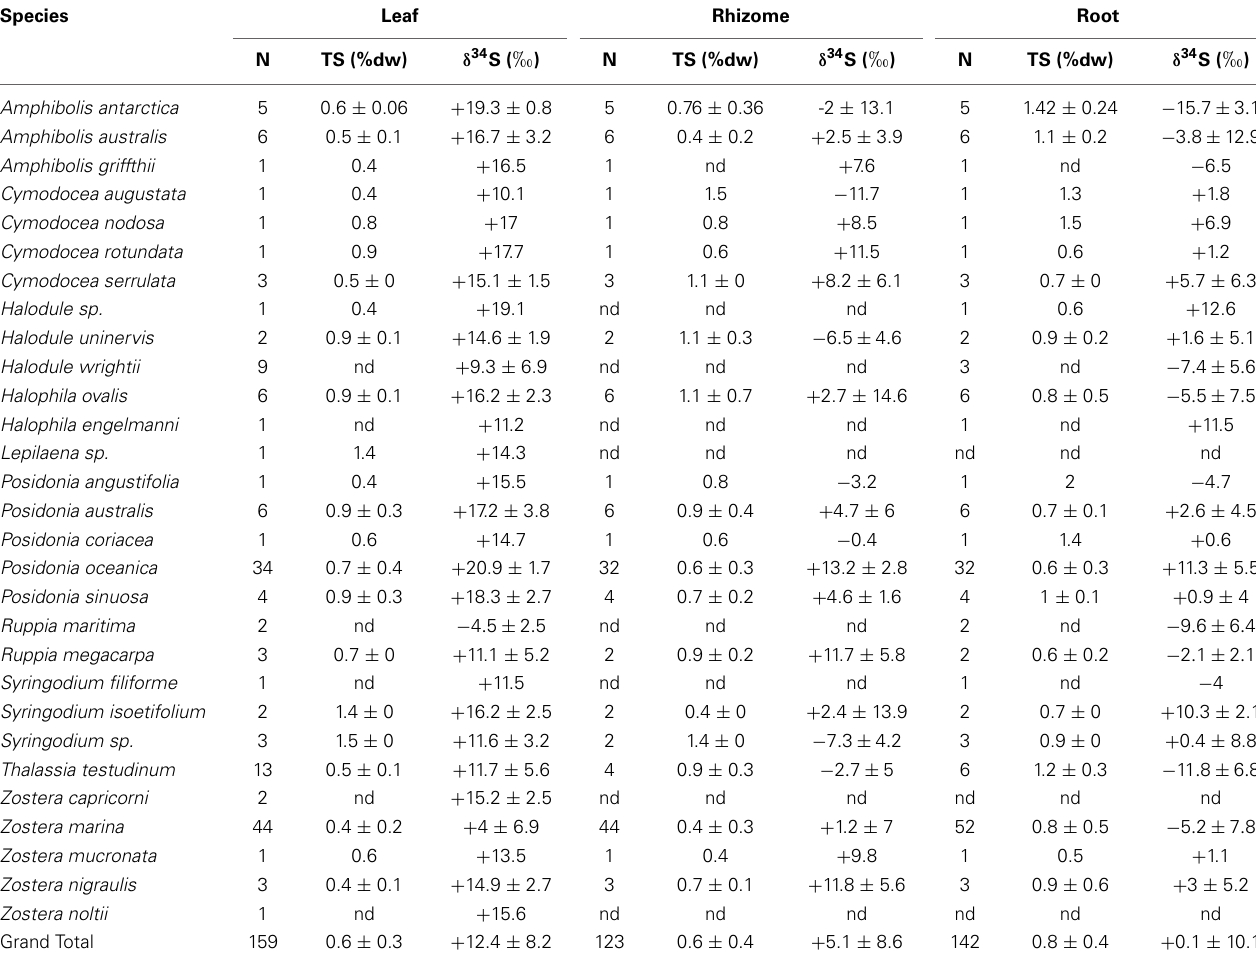
Table 2 | δ 34 S of leaves, rhizomes and roots of several seagrass species, references are reported in the supplementary material. Species Leaf Rhizome